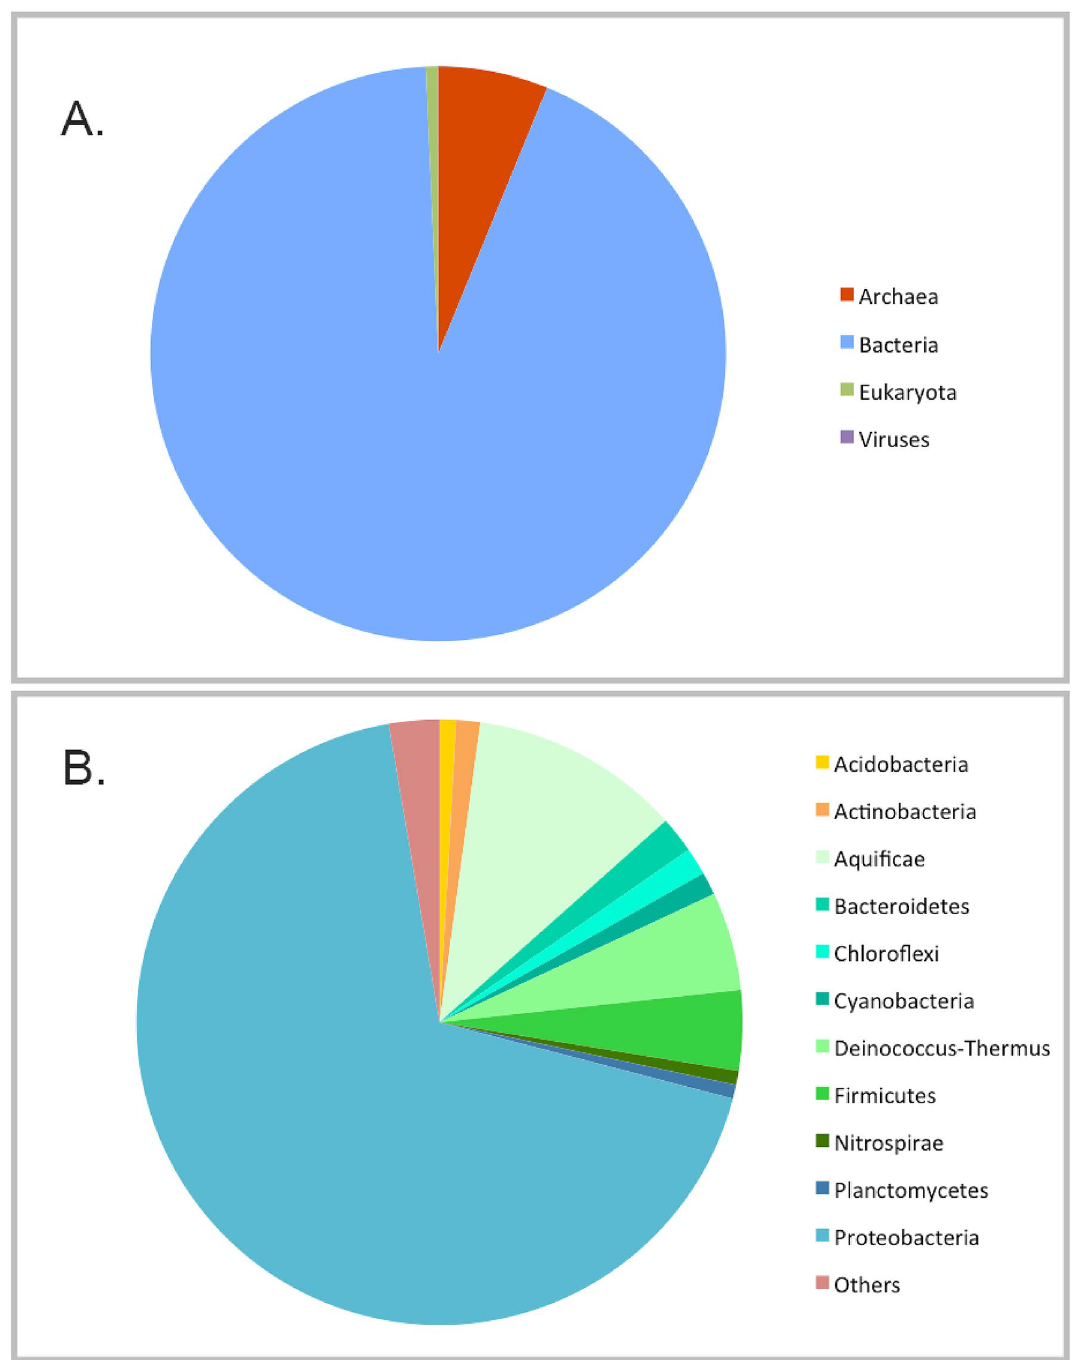
Figure 1. ( A ) Taxonomic assignment of the reads at domain level. The chart represents the percentage of reads assigned to each domain (relative abundance expressed as a percentage from the total assigned reads). ( B ) Taxonomic assignment of sequences within Bacteria domain. Percentage of reads annotated at phylum level is represented. Others include those phyla with less than 0.7% sequences assigned (Candidatus Poribacteria, Chlamydiae, Chlorobi, Chrysiogenetes, Deferribacteres, Dictyoglomi, Elusimicrobia, Fibrobacteres, Fusobacteria, Gemmatimonadetes, Lentisphaerae, Spirochaetes, Synergistetes, Tenericutes, Thermotogae, unclassified (derived from Bacteria) and Verrucomicrobia). Graphs were created with Excel for Windows version